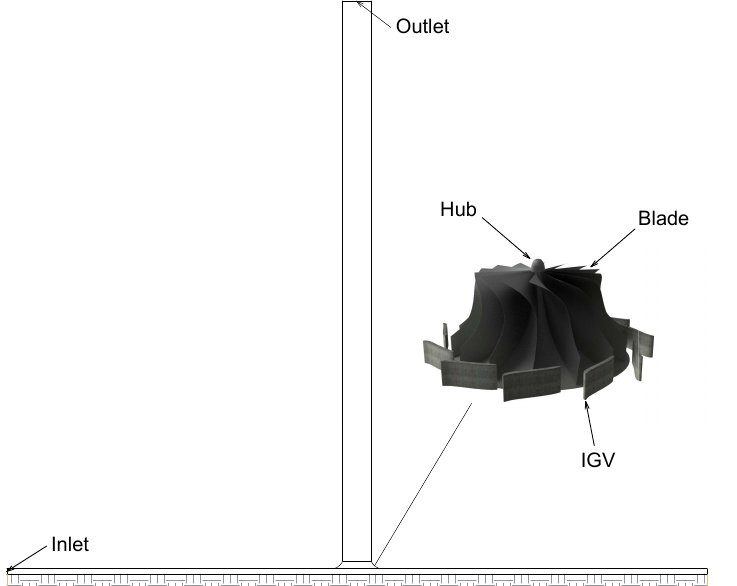
Figure 4. Schematic of the proposed radial turbine using Manzanares SCPP